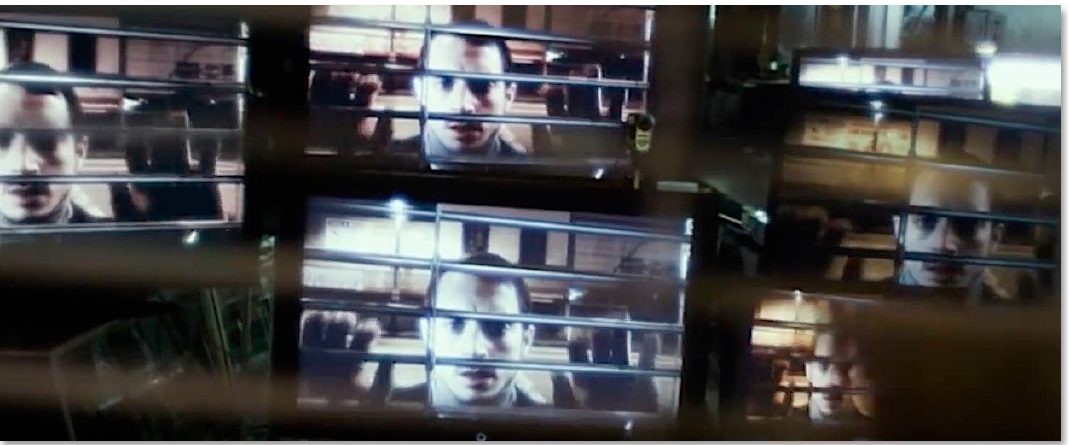
Figure 20. Image from Maniac (2012) [48].